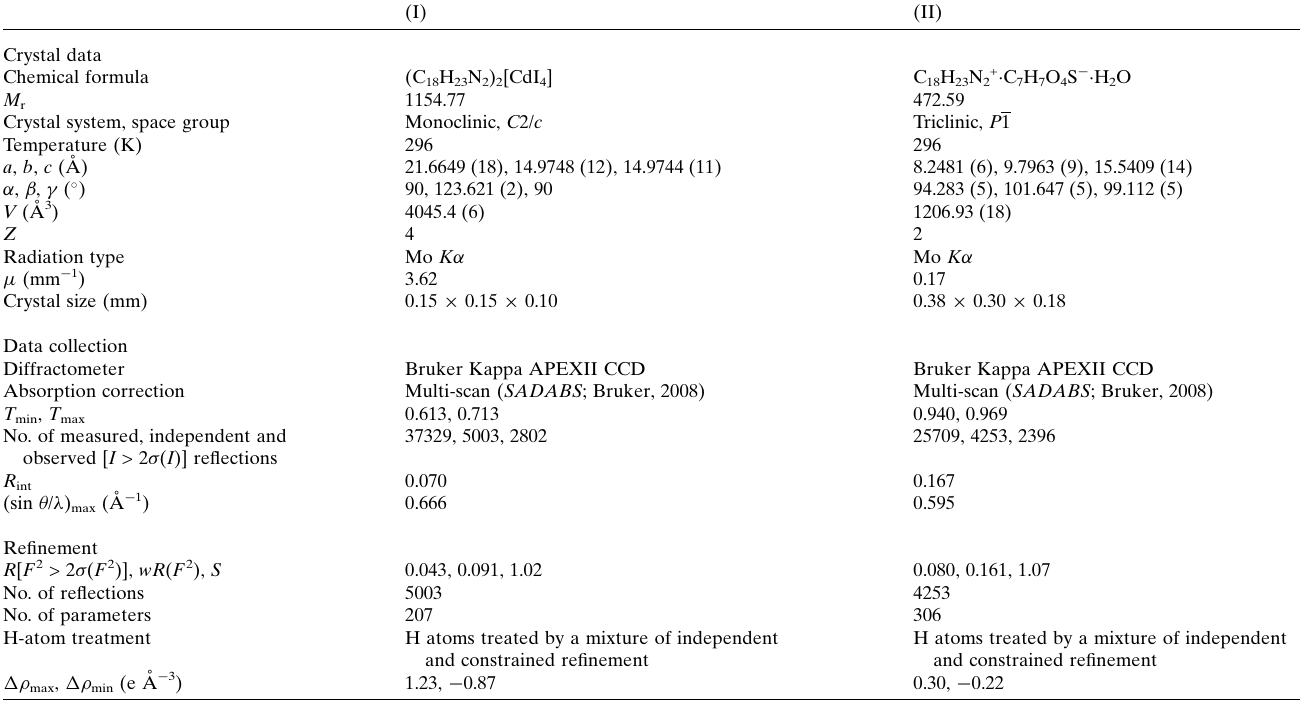
Crystal data Chemical